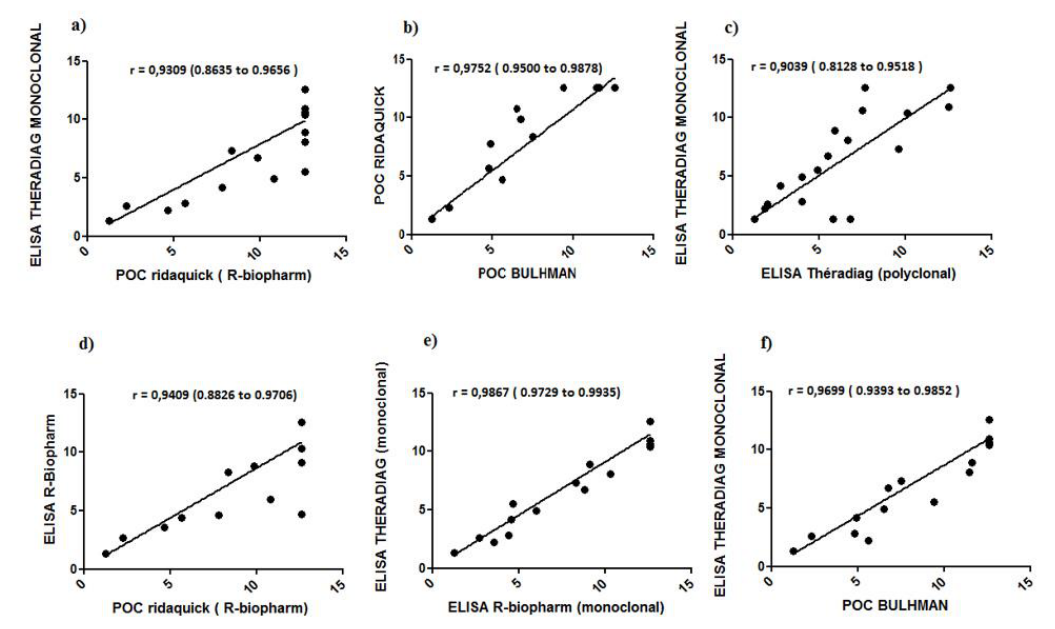
Figure 3. Nonparametric Spearman correlation between the different assays. ( a ) ELISA Theradiag (monoclonal) vs. POC R-Biopharm (Ridaquick), ( b ) POC R-Biopharm (Ridaquick) vs. POC Buhlmann (Quantum Blue), ( c ) ELISA Theradiag (monoclonal) vs. ELISA Theradiag (polyclonal), ( d ) ELISA R-Biopharm (Ridascreen) vs. POC R-Biopharm (Ridaquick), ( e ) ELISA Theradiag (monoclonal) vs. ELISA R-Biopharm (Ridascreen), ( f ) ELISA Theradiag (monoclonal) vs. POC Buhlmann (Quantum Blue).